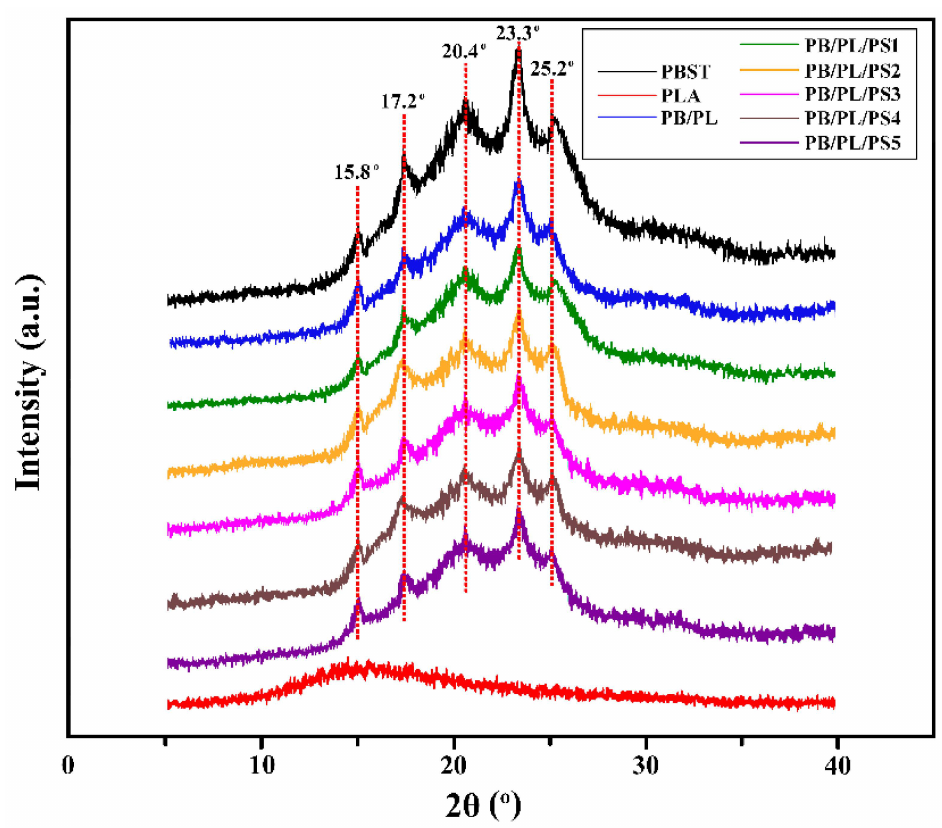
Figure 3. XRD spectra of neat PBST, PLA, and PBST/PLA blends with various amounts of